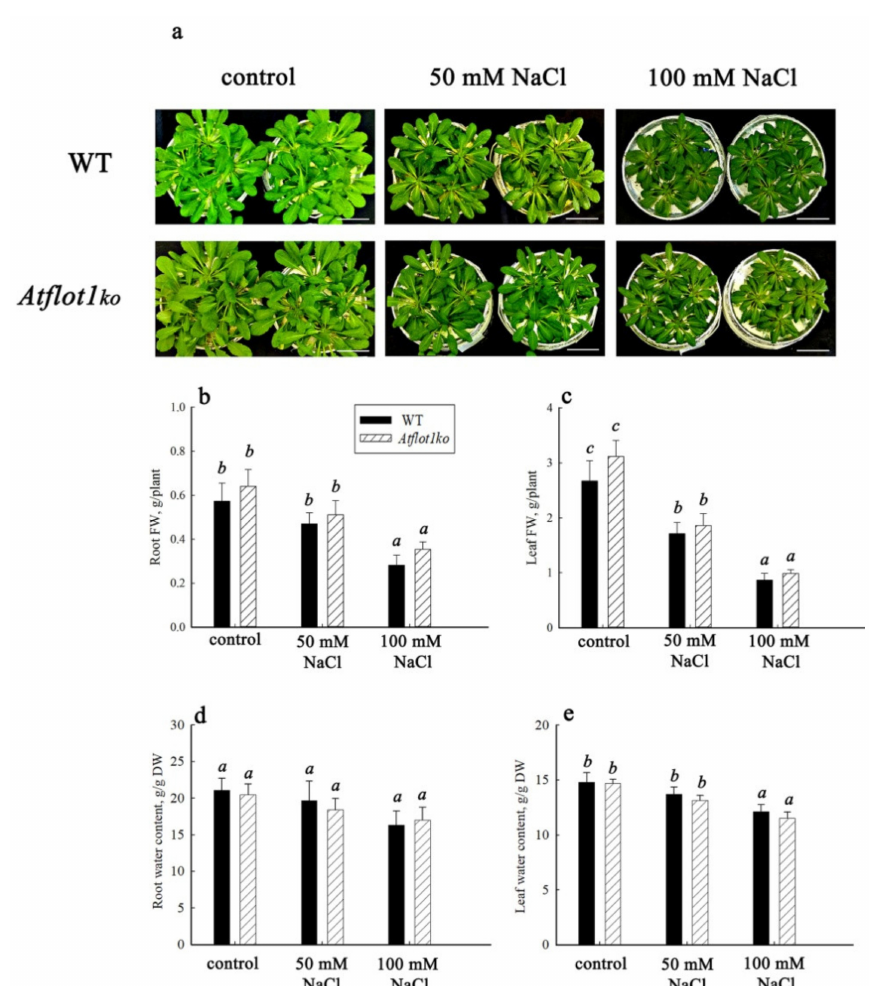
Figure 2. Growth characteristics of A. thaliana WT and Atflot1ko mutant plants and hydration levels of the plant organs. The plants were grown either in the absence (control) or presence of NaCl in the nutrient solution (NS) at final concentrations of 50 or 100 mM; ( a ) general view of plants, scale bar—5 cm; ( b , c ) fresh weight (FW) of roots and leaves; ( d , e ) water content in roots and leaves. Means ± SE are given ( n = 3, average weight from 16 plants in each of the repetition). Different letters indicate statistically significant differences between the samples (ANOVA; p <